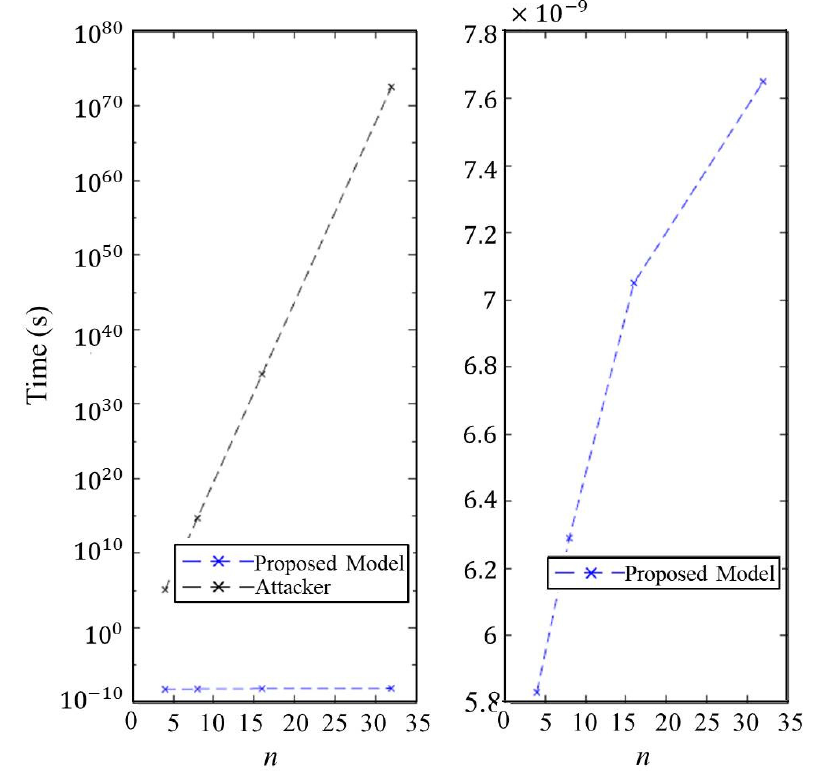
Figure 20. Execution time of an attacker and STT-DPSA to do authentication under k = 8 and l = 2 while varying the parameter n